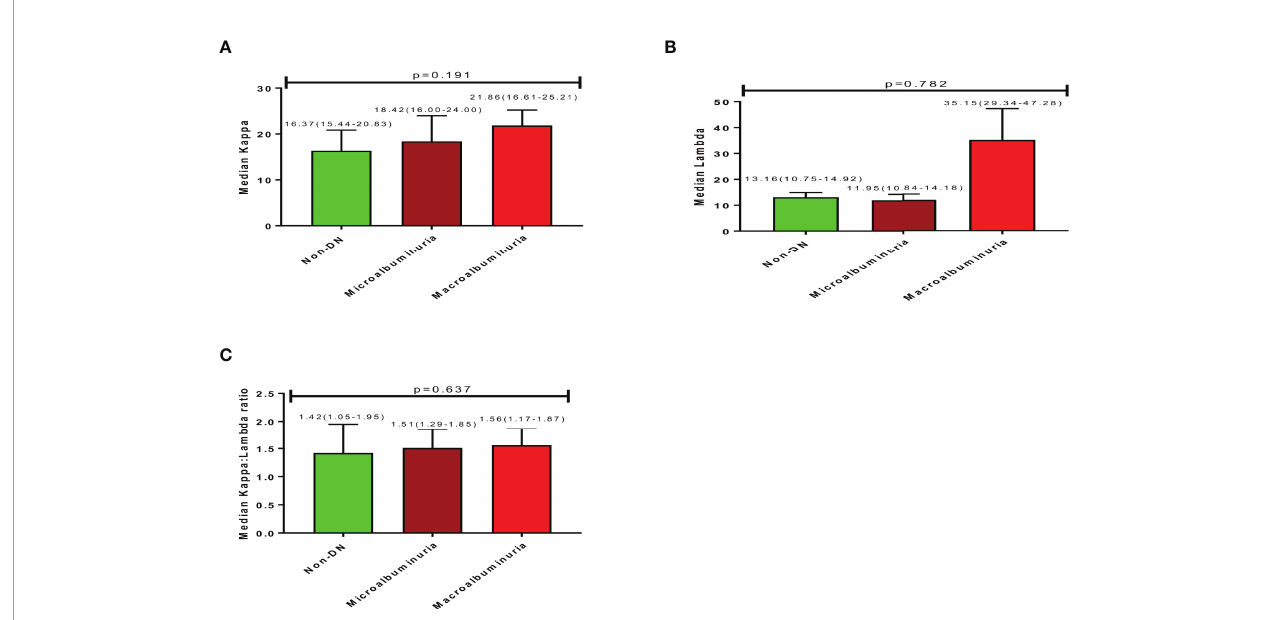
FIGURE 2 | Free light chain pro fi le of the study participants showing (A) (Median Kappa), (B) (Median Lambda), (C) (Median Kappa:Lambda